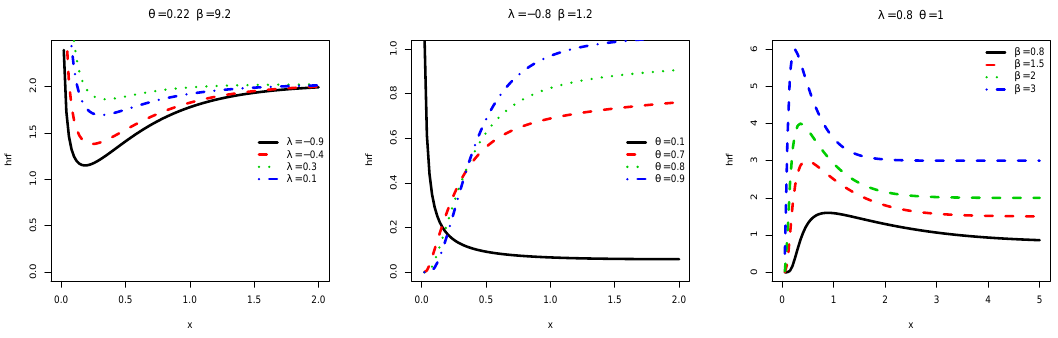
Figure 2. A panel of shapes for the hrf of the TOFrE distribution.